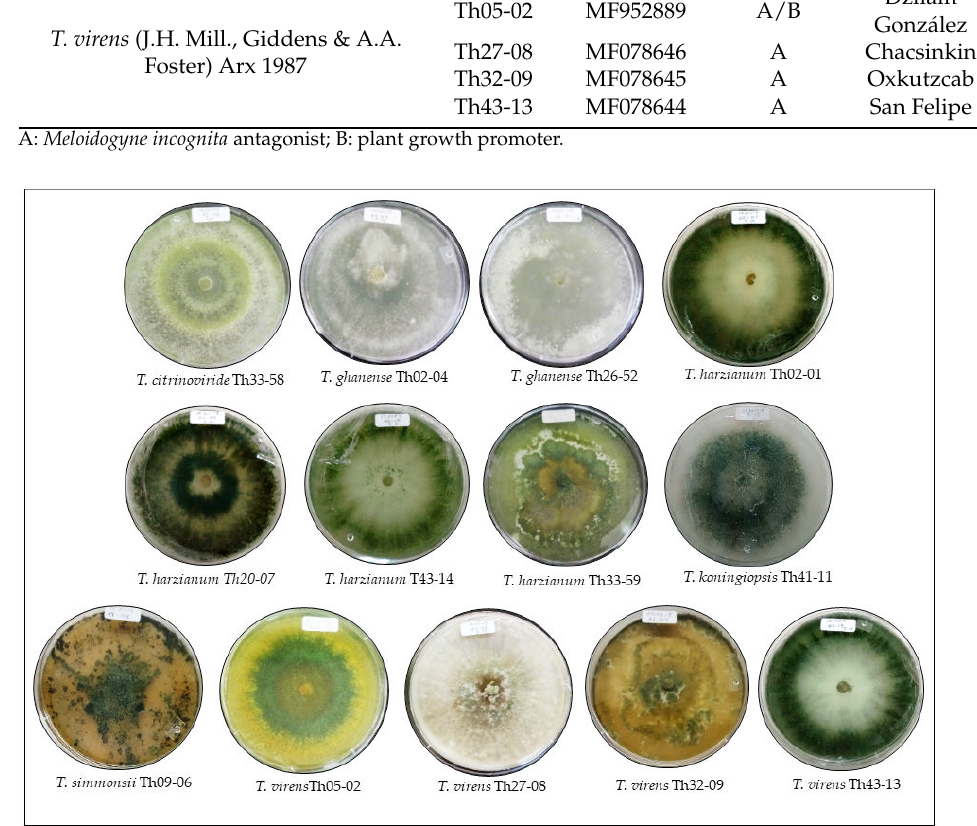
Figure 1. Cultures of the 13 study strains of Trichoderma on potato dextrose agar incubated at 25 ± 2 25 ± 2 ◦ C, 12 h light/12 h dark for 8 °C, 12 h light/12 h dark for 8 days.